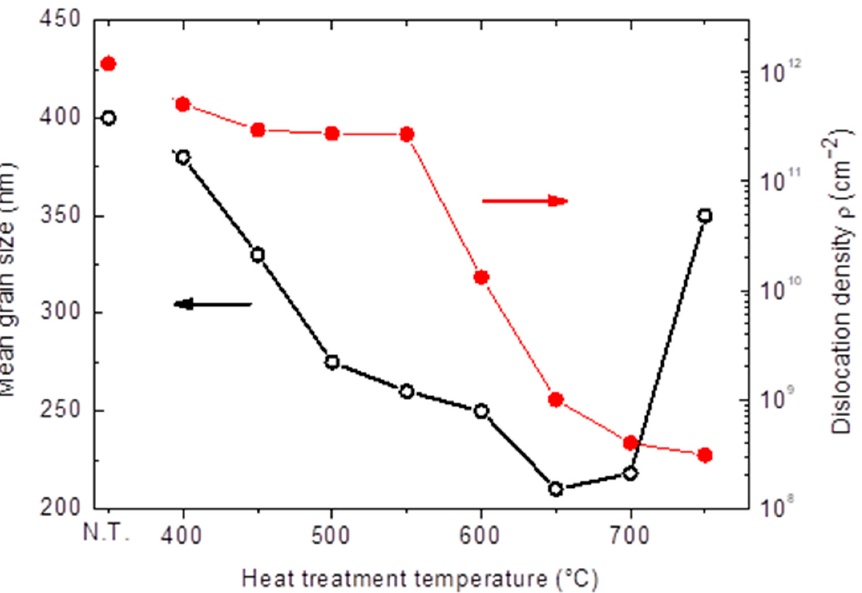
Figure 11. Mean grain size, D, and dislocation density, ρ , determined from the analysis of XRD peak profiles of the steel cold-rolled with a CR ratio of 80% and heat-treated at temperatures in the range 400–750 °C (step 50 °C). 400–750 ◦ C (step 50 ◦ The effect on hardness of heat treatments for 1 h at eight temperatures on samples